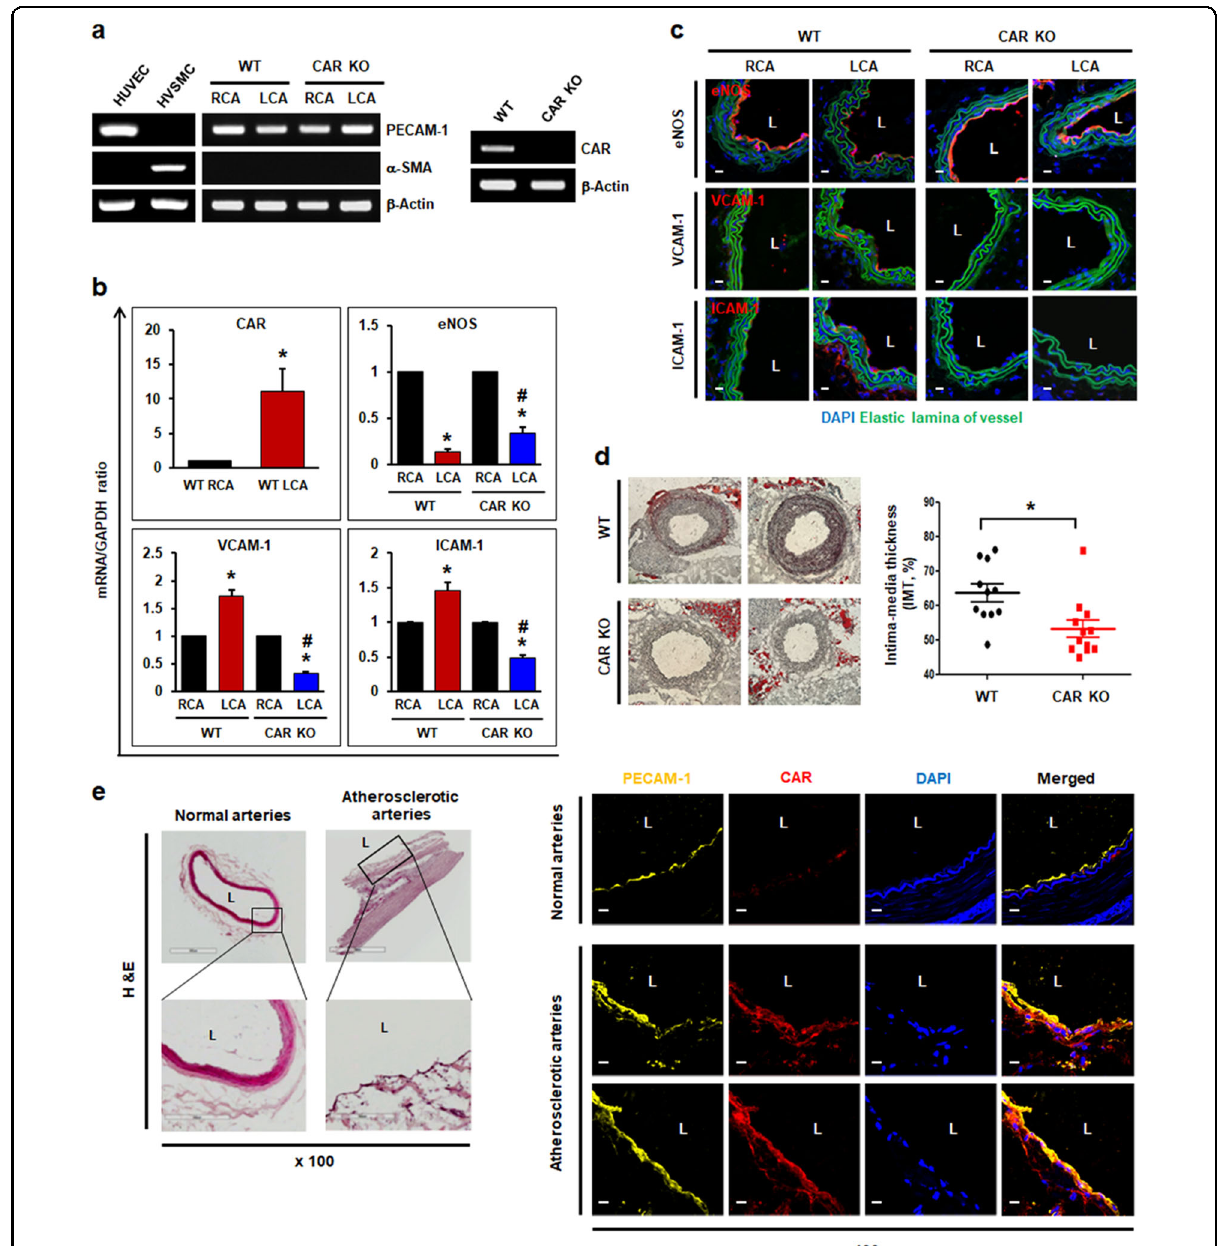
Fig. 4 CAR deletion protects the proatherogenic endothelium under disturbed fl ow. Wild-type (WT) C57BL/6 or EC-speci fi c CAR KO mice were partially ligated in the LCA. a Twenty-four hours after LCA ligation, the mice were euthanized, and EC-enriched RNA was extracted from both carotid arteries. EC-enriched RNA was con fi rmed by assessing an endothelial-speci fi c marker (PECAM-1), a smooth muscle cell-speci fi c marker ( α -smooth muscle actin [ α -SMA]), and β -actin (internal control). HUVECs were used as a positive control for PECAM-1 and a negative control for α -SMA. Human vascular smooth muscle cells (VSMCs) were used as a positive control for α -SMA and a negative control for PECAM-1. The knockout of endothelial CAR in EC-speci fi c CAR KO mice was con fi rmed by RT-PCR. Representative images are shown ( n = 5). b Levels of mRNAs encoding eNOS, VCAM-1, and ICAM-1 in EC-enriched RNA were determined by real-time PCR ( n = 5; * P < 0.05, WT RCA vs. WT LCA, CAR KO RCA vs. CAR KO LCA; # P < 0.05, WT LCA vs. CAR KO LCA). c Immuno fl uorescence staining was performed in carotid arteries from WT or EC-speci fi c CAR KO mice. Representative images are shown ( n = 3; red, eNOS, VCAM-1, or ICAM-1; blue, nuclei; green, elastic lamina of vessel; scale bars, 10 μ m). d Disturbed fl ow-induced atherosclerotic plaque formation was visualized in ligated LCA by Oil Red O staining. We measured the IMT by calculating the luminal area relative to the total vascular area. Representative images are shown ( n = 11; * P < 0.05, WT vs. CAR KO). e Human arterial tissues were stained with hematoxylin and eosin (H&E) and anti-PECAM-1 and anti-CAR antibodies. PECAM-1 was used as an endothelial-speci fi c marker. Expression of CAR was compared between normal and atherosclerotic regions of arterial tissue by confocal microscopy. Representative images from at least three experiments are shown (red, CAR; yellow, PECAM-1; blue, nuclei). Scale bars, 10 μ